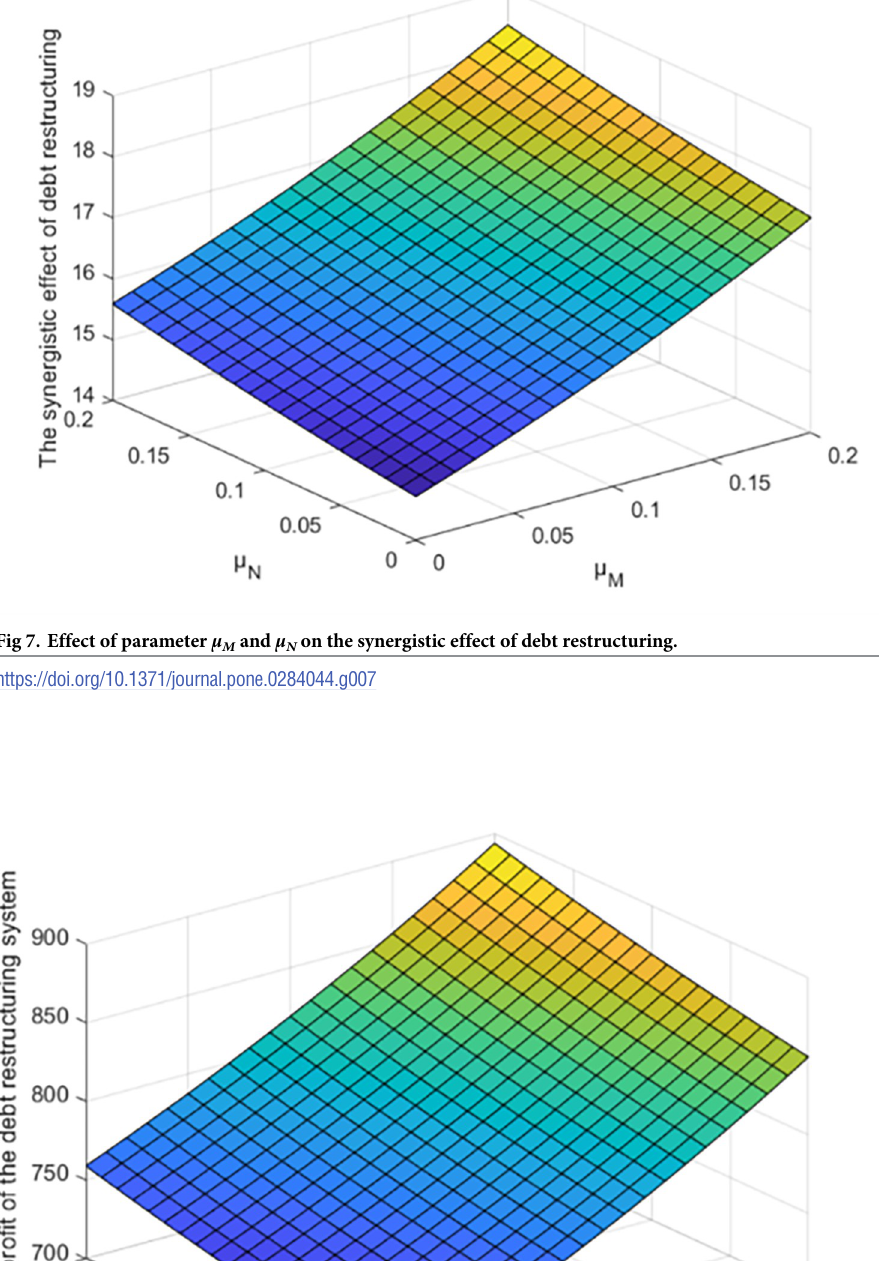
Fig 8. Effect of parameter μ M and μ N on total profit of debt restructuring.